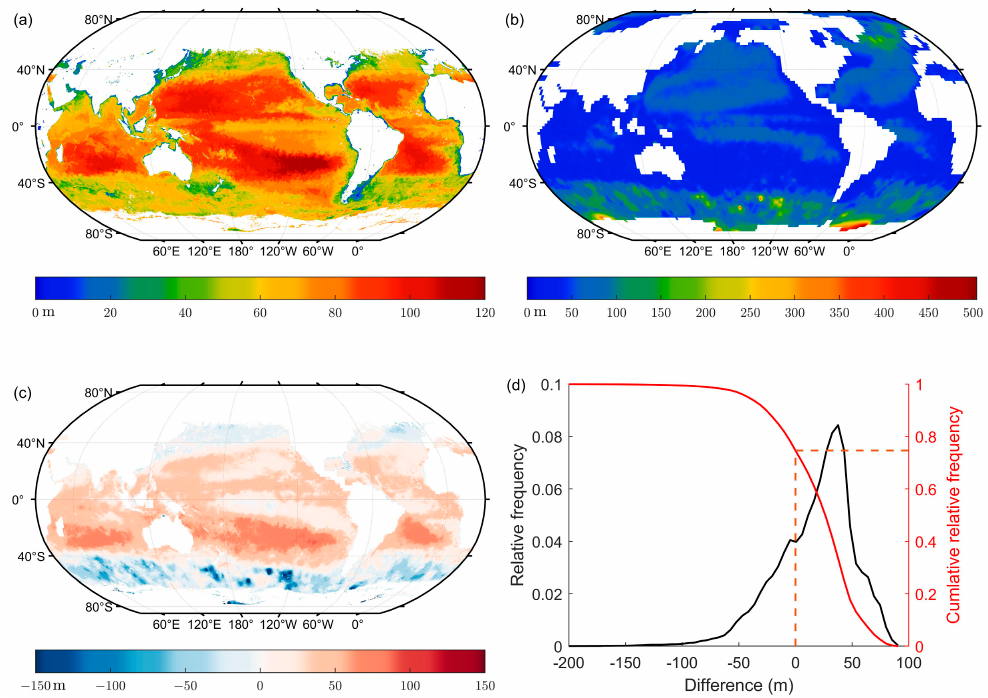
Figure 23. Comparison between lidar maximum detectable depth and MLD in the autumn (the northern hemisphere). Distribution of the lidar maximum detectable depth at daytime ( a ), mixed layer depth ( b ), the difference between lidar maximum detectable depth and mixed layer depth ( c ), and the relative frequency distribution of the difference ( d ).